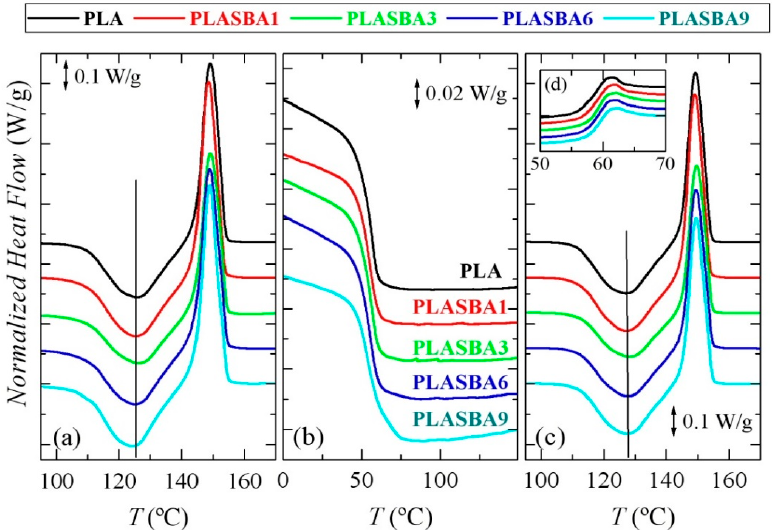
Figure 5. DSC curves performed at 10 °C/min for PLA and its composites with SBA-15, normalized to the actual PLA amount: ( a ) first heating, ( b ) cooling from the melt, ( c ) second heating, and ( d ) interval for glass transition during second heating.